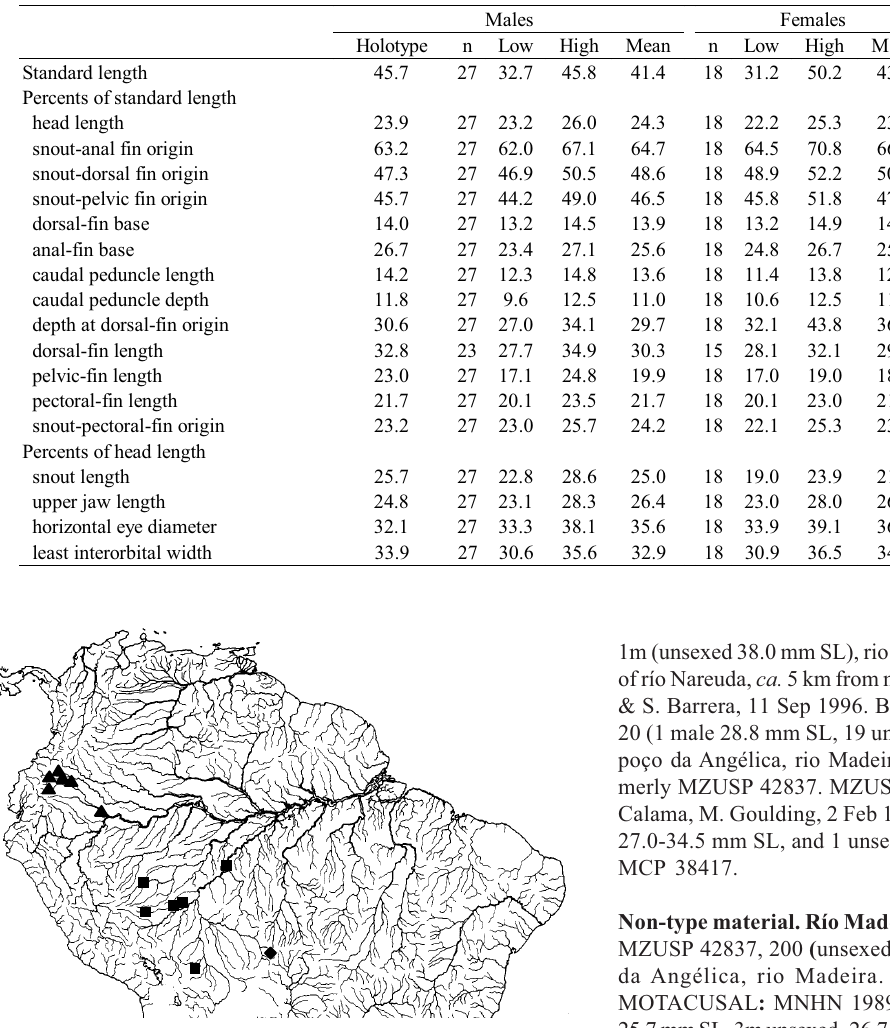
Holotype. CBF 09621, 1 (male 33.1 mm), Bolivia, Pando, [río Orthon - rio Madeira basin], lake on right bank of río Nareuda, around 3-4 km above mouth of río Tahuamanu, H. Ortega et al ., 10 Sep 1996. Paratypes. BOLIVIA, PANDO: FMNH 106433, 4m of 17 (2 males 29.4-31.4 mm SL, 1 male 31.6 mm SL c&s, 1 female? 32.3 mm SL, 13 unsexed 19.5-27.1 mm SL not measured), same data as holo- type. FMNH 106428, 1m (unsexed 30.9 mm SL), rio Madeira ba- sin, lake on the right bank of río Nareuda, ca. 3-4 km above mouth of río Tahuamanu, H. Ortega et al ., 10 Sep 1996. FMNH 106430,